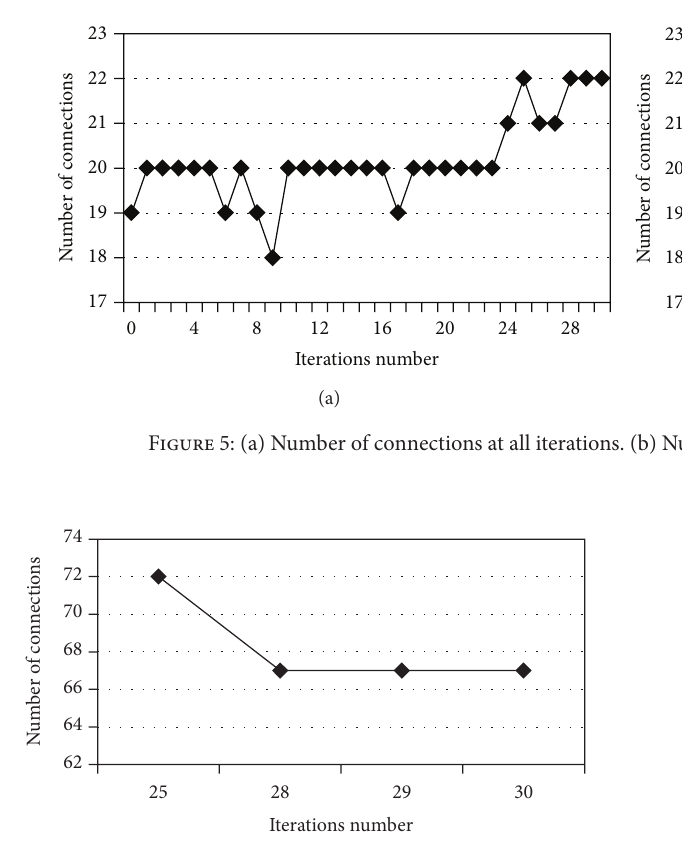
Figure 6: The algorithm gradually decreases the energy level among 𝑅 = 22 .